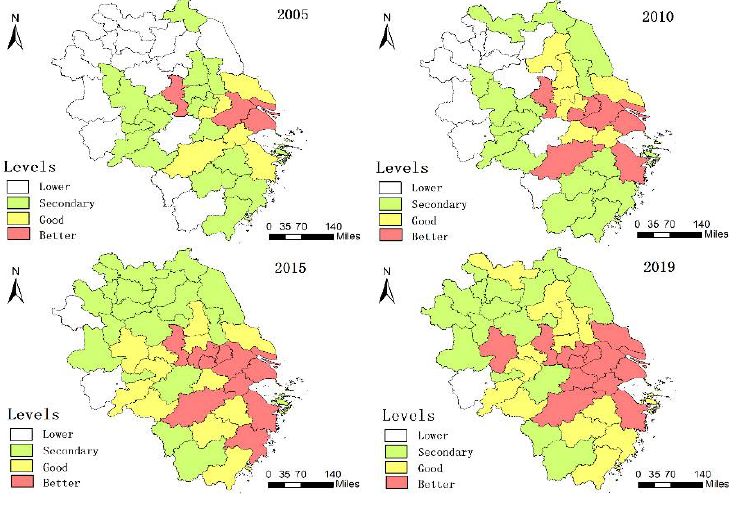
Figure 5. Map of development level of open economy in YRDA from 2005 to 2019.